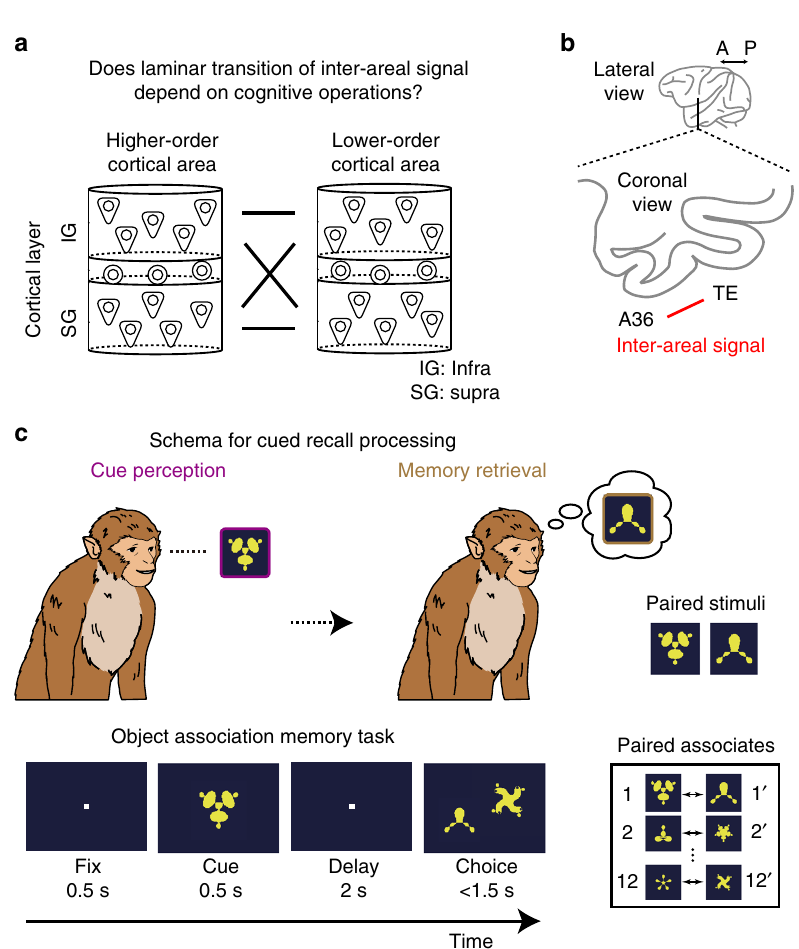
Fig. 1 Schematic models of cortical laminar transition of the inter-areal signal. a It remains elusive whether the laminar transition of inter-areal signal between higher-order and lower-order cortical areas depends on cognitive operations. IG infragranular layer, SG supragranular layer. b Lateral and coronal views of a monkey brain. A36, area 36. TE, area TE. A, anterior. P, posterior. c Behavioral task. To characterize laminar speci fi city of inter-areal interaction during cue perception and memory retrieval in cued-recall, an object association memory task was used. In the task, monkeys were required to retrieve the learned paired associate of the presented cue stimulus. See Methods for